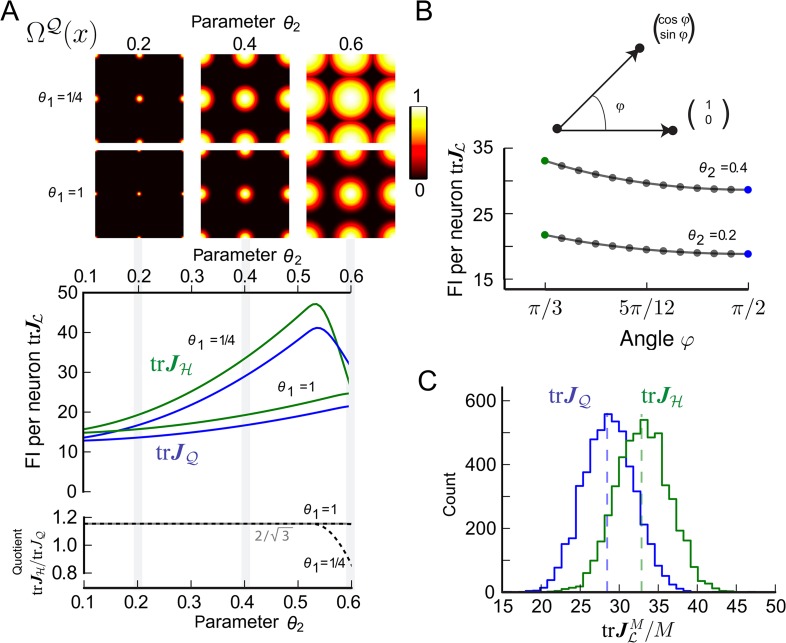
Fisher information for modules of two-dimensional grid cells.(A) Top: Periodified bump-function Ω and square lattice L, for various parameter combinations θ1 and θ2. Here, θ1 modulates the decay and θ2 the support. Middle: Average trace trJL of the Fisher information (FI) for uniformly distributed grid cells ΩL. Hexagonal (H) and square (Q) lattices are considered for different θ1 and θ2 values. The FI of the hexagonal grid cells outperforms the quadratic grid when support is fully within the fundamental domain (θ2 < 0.5, see main text). Bottom: Ratio trJH/trJQ as a function of the tuning parameter θ2. For θ2 < 0.5, the hexagonal population offers 3/2 times the resolution of the square population, as predicted by the respective packing ratios. (B) Average trJL for grid cells distributed uniformly in lattices generated by basis vectors separated by an angle φ (basis depicted above graph). trJL behaves like 1/sin(φ) and has its maximum at π/3. (C) Distribution of 5000 realizations of trJLM/M at 0 for a population of M = 200 randomly distributed neurons. For both the hexagonal and square lattice, parameters are θ1 = 1/4 and θ2 = 0.4. The means closely match the average values in (A). However, due to the finite neuron number the FI varies strongly for different realizations, and in about 20% of the cases a square lattice module outperforms a hexagonal lattice.